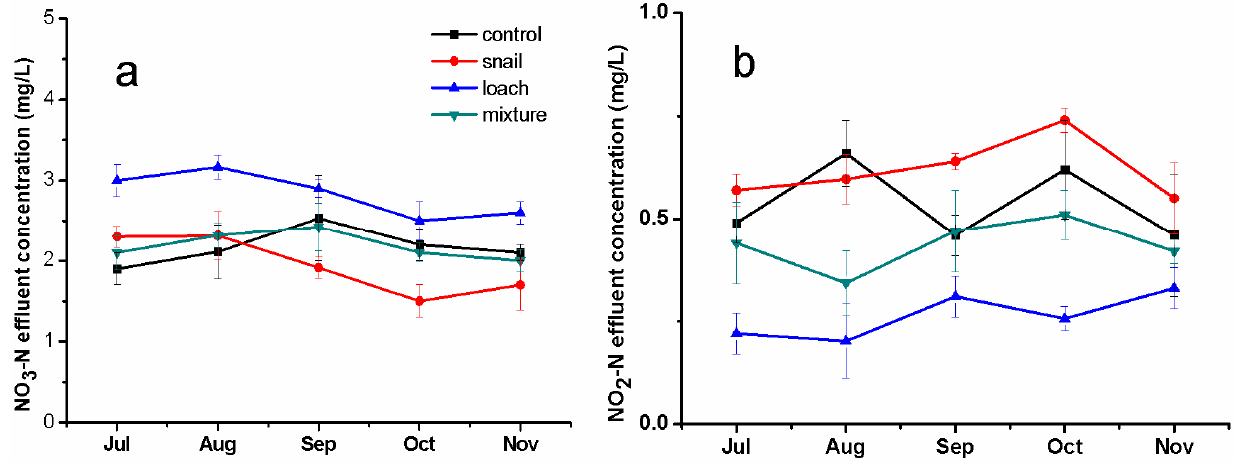
Figure 3. NO 3 -N ( a ) and NO 2 -N ( b ) concentrations of effluent.